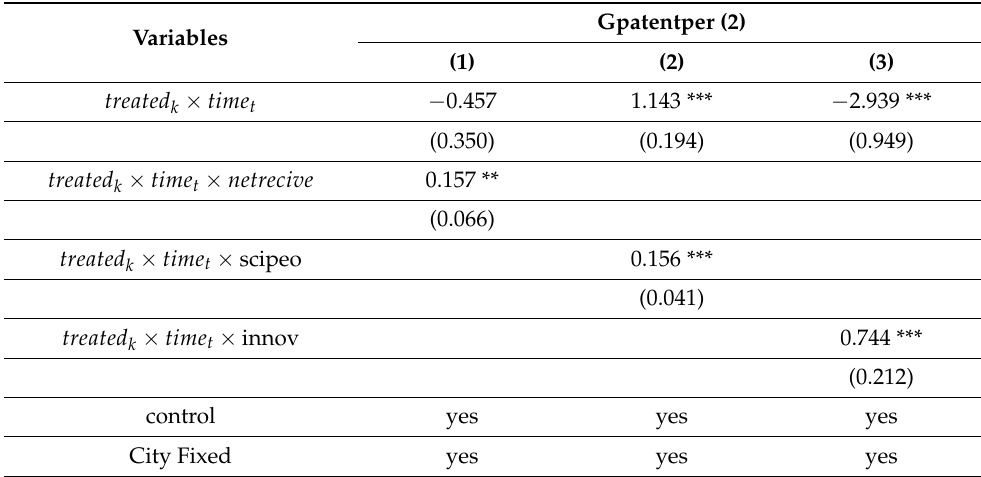
Table 7. Impact mechanism